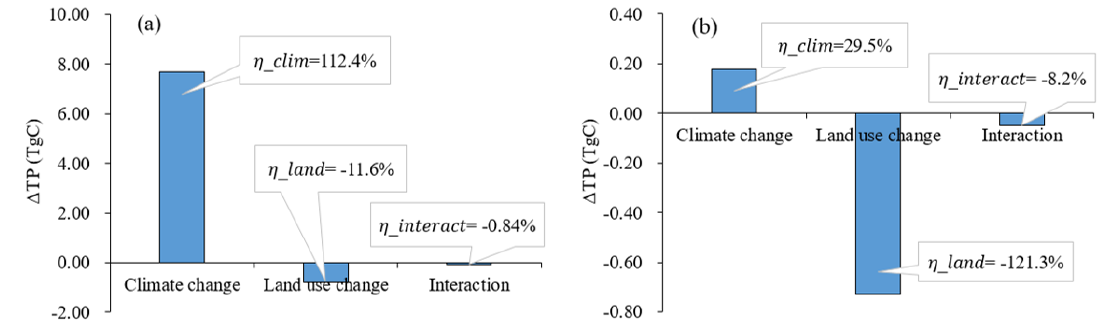
Figure 9. The impacts of climate change, land-use change, and the interaction term on the change of TP